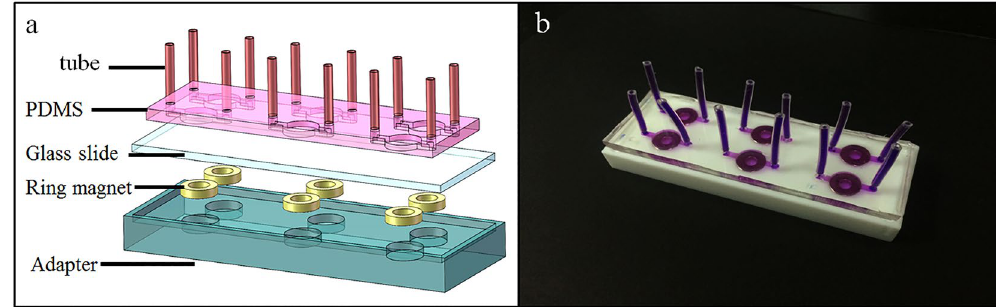
Figure 1. Images of the integrated cell isolation and migration device. ( a ) Schematic diagram of the device that is composed of a PDMS microfluidic chip with six cell culture channels, a glass slide, six ring magnets and an adapter. ( b ) Photograph of the real device used in this experiment. Purple ink is used to display the microfluidic